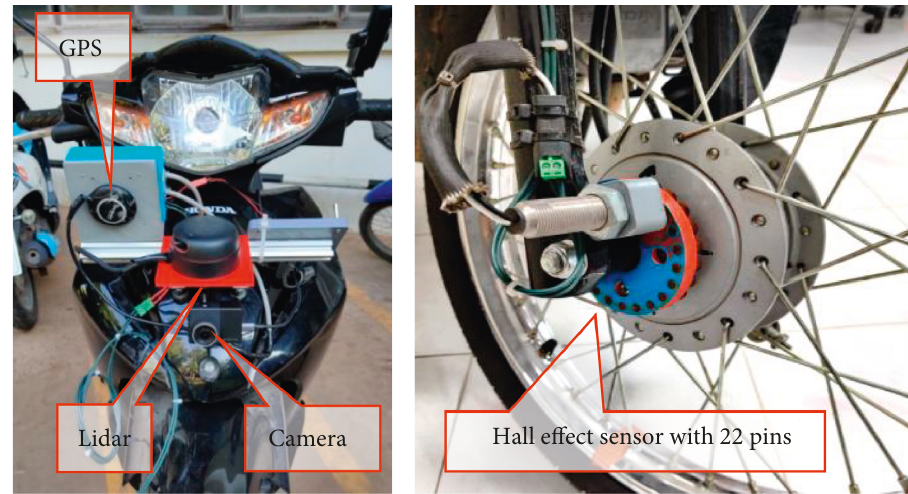
Figure 3: Installation of the developed measurement device on a test